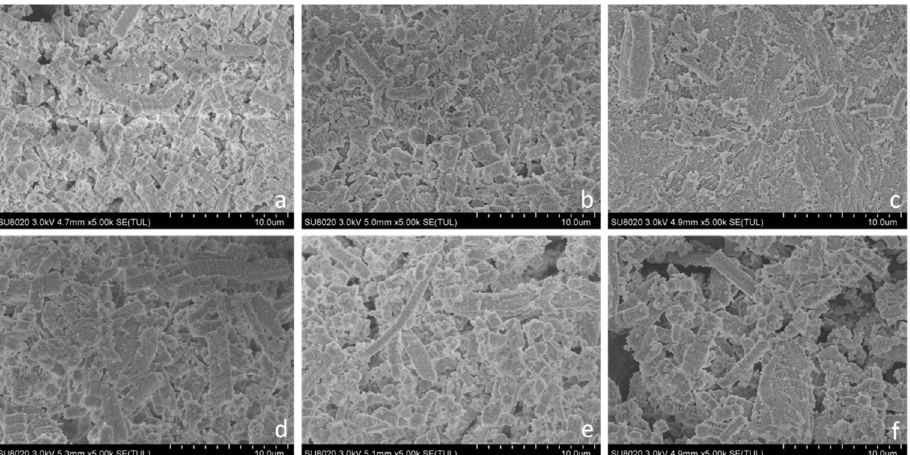
Figure 5. SEM photographs (5000 ×) of MP gels oxidatively stressed in the presence and absence of FOs at different concentrations: ( a ) NOX, nonoxidized; ( b ) 0; ( c ) 50 μ mol/g FOs; ( d ) 100 μ mol/g FOs; FOs at different concentrations: ( a ) NOX, nonoxidized; ( b ) 0; ( c ) 50 µ mol/g FOs; ( d ) 100 µ mol/g FOs; ( e ) 150 μ mol/g FOs; and ( f ) 200 μ mol/g FOs. ( e ) 150 µ mol/g FOs; and ( f ) 200 µ mol/g